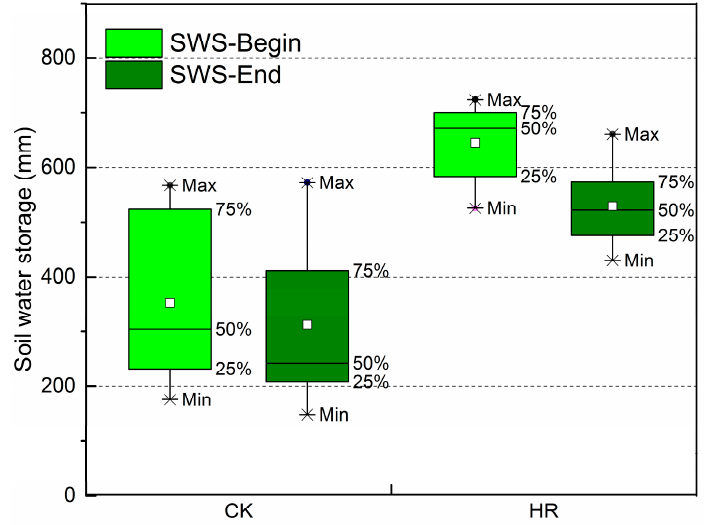
Figure 3. SWS statistics during the growing season. SWS-Begin represents SWS at the beginning of the growing season; SWS-End represents SWS at the end of the growing season.